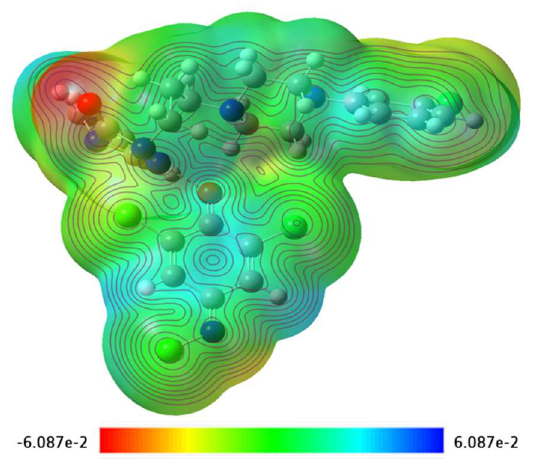
Figure 17. MEP surface map of the CT complex [(TZD)(DCQ)] with respective color scales.